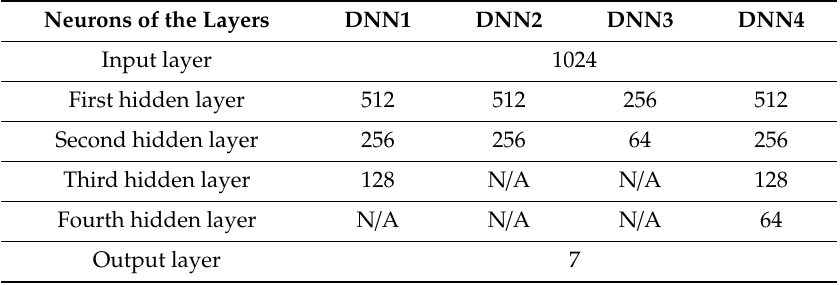
Table 4. The detail of four deep neural networks (DNN) models for radar emitter signal recognition.